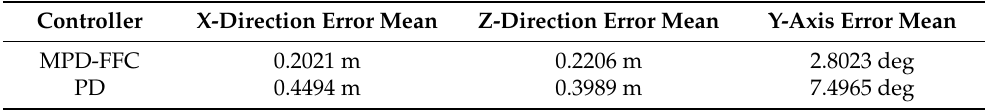
Table 4. The position error mean values with different